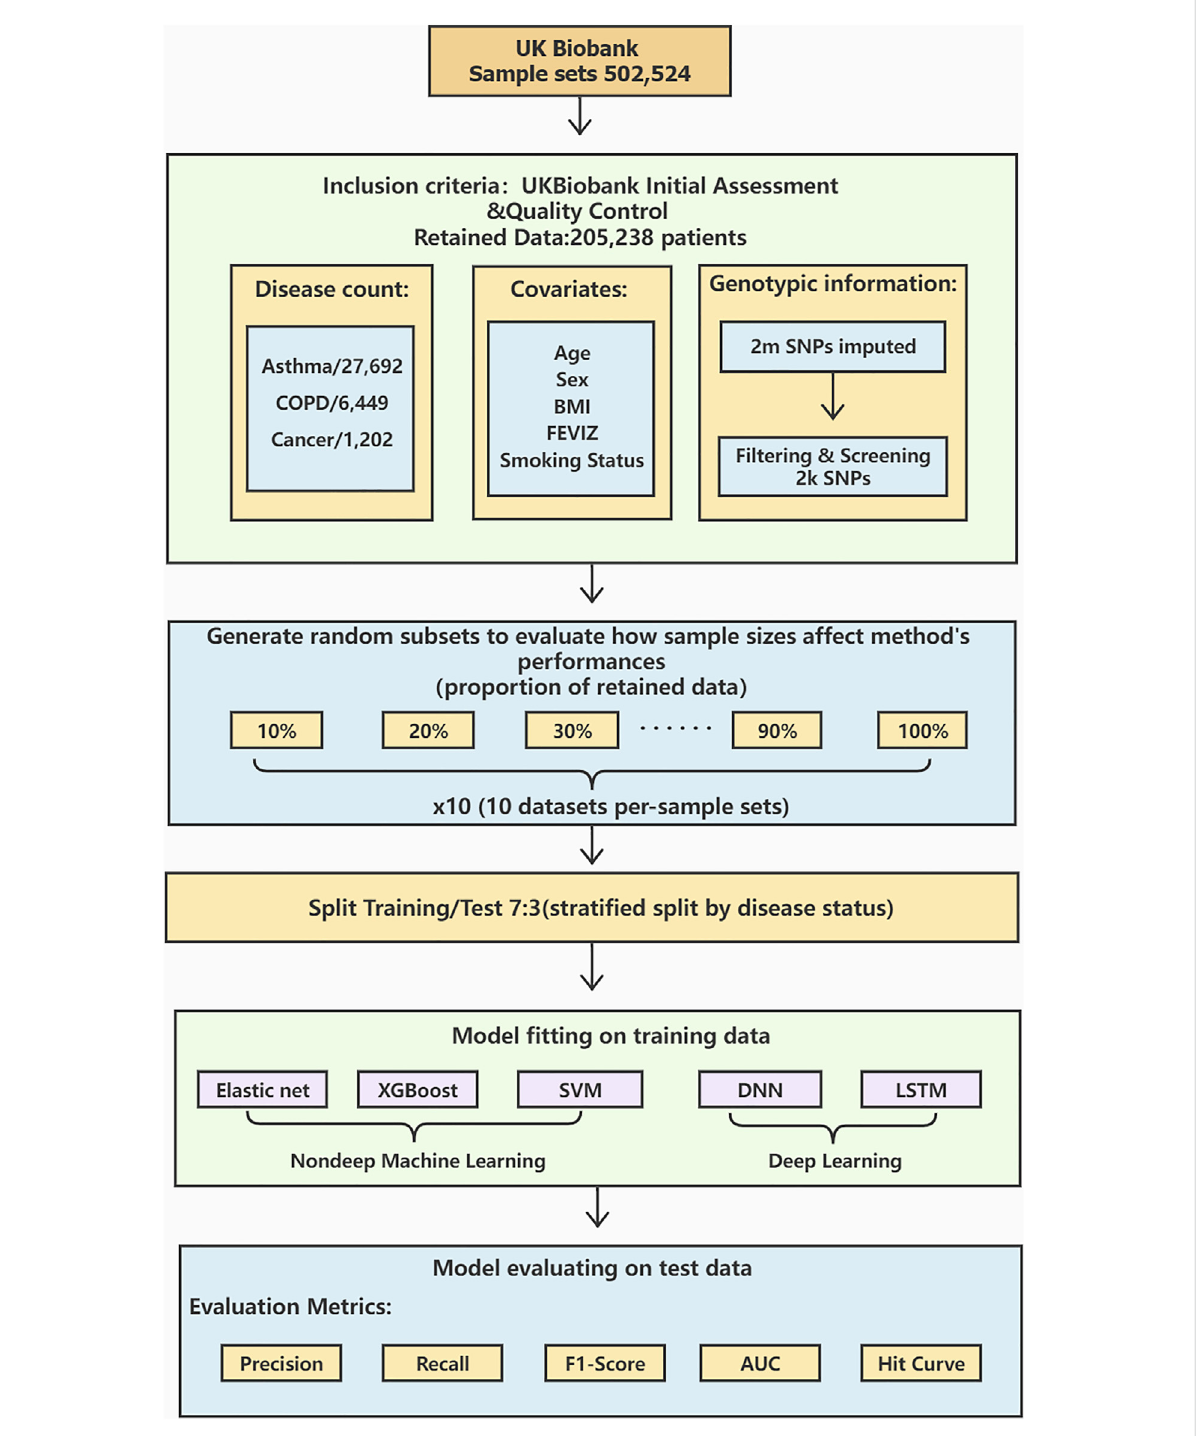
FIGURE 1 Awork fl owdiagramofthestudyprocess. Weperformdatapreprocessing on502,524samplesetsfromUKBiobank.Aftertheinitialassessment and quality control, the data is retained for 205,238 cases with detailed procedures in. There are 27,692 asthma cases, 6,449 COPD cases, and 1,202 lung cancer cases. Age, sex, BMI, FEVIZ, and smoking status are covariates. 2,000 SNPs are retained after fi ltering and screening the original 2 million SNPs. The retained dataset was divided into ten subsets per-sample sets from 10 to 100%. We split the data by disease status into 70% astrainingand30%astestingsets.Thisstudyusesthreenon-deepMLmodels(Elasticnet,XGBoost,andSVM)andtwoDLmodels(DNNandLSTM)to construct the prediction models. Finally, the model performance is evaluated by the metrics, such as precision, recall, F1-score, AUC, and hit